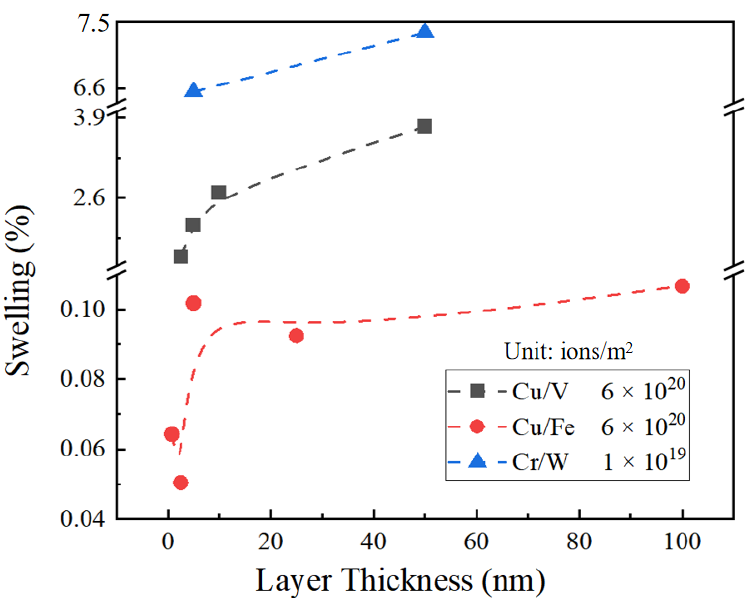
Figure 12. The relationship between the layer thickness of Cu/V [5], Cu/Fe [56], and Cr/W [114] multilayer films and the swelling rate after irradiation. The swelling rate declines with decreasing layer thickness.